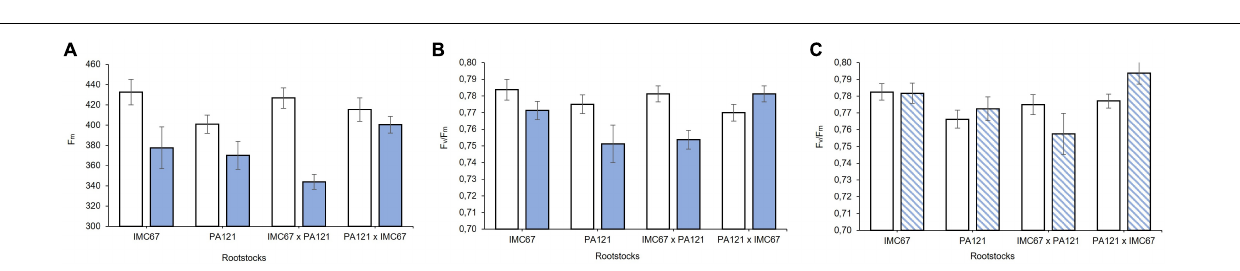
PA121 OP half-sib progenies, compared with the control. Mn content respectively decreased by 10.9, 24.4, 11.5, and 21.5% for PA121 and IMC67 OP half-sib, and PA121 × IMC67 and IMC67 × PA121 full-sib families, in relation to the